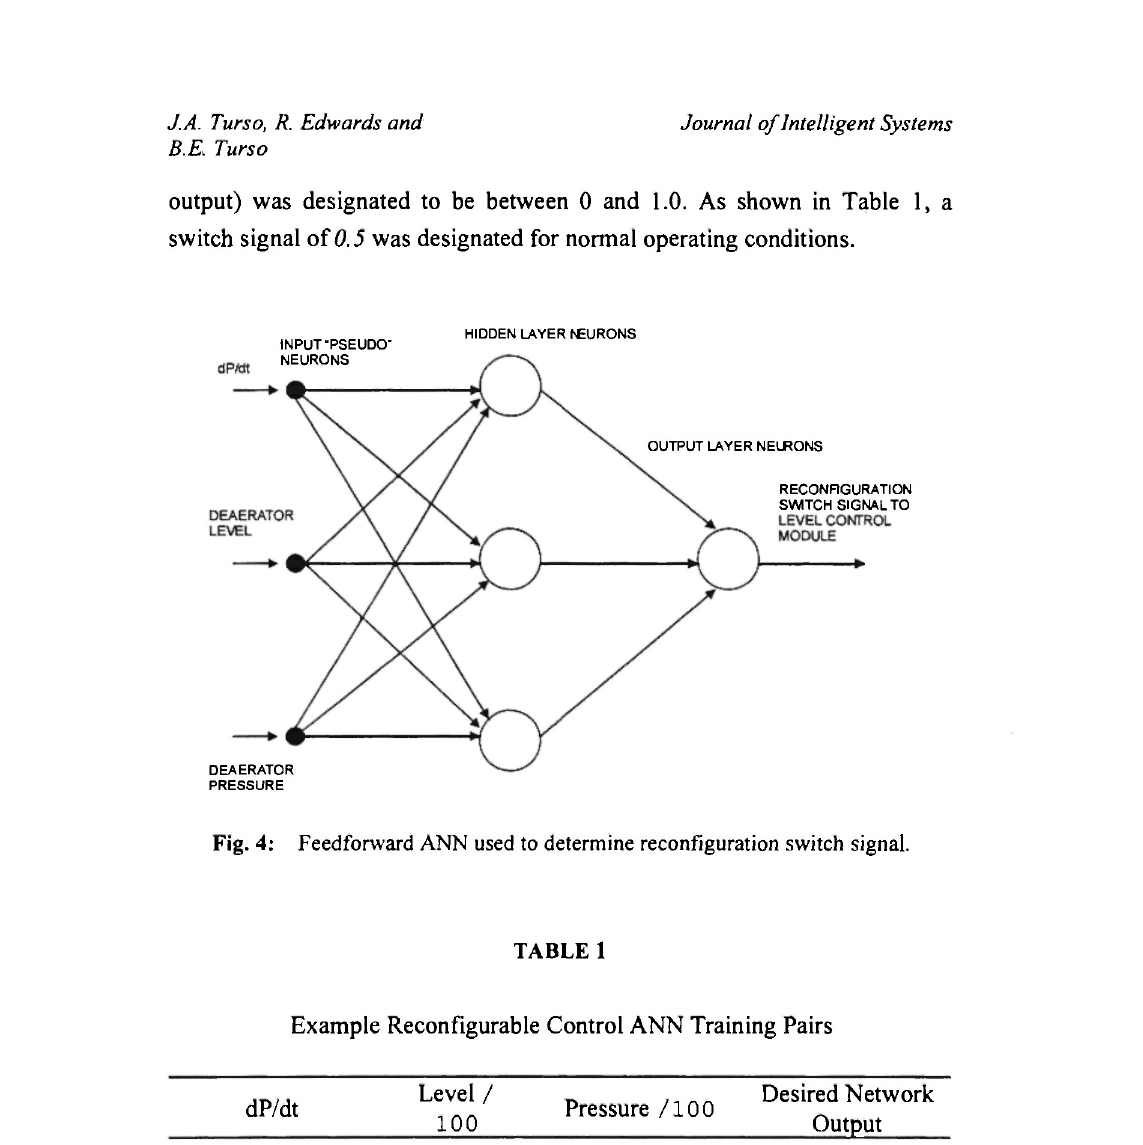
Example Reconfigurable Control ANN Training